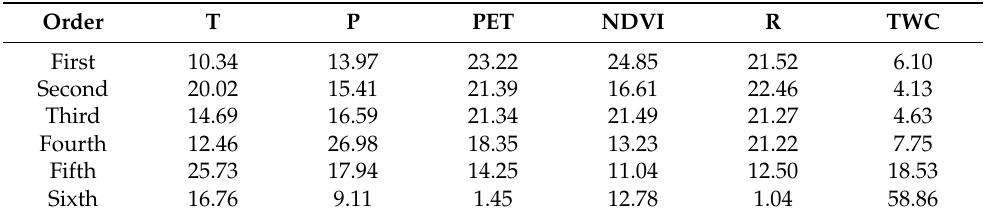
Figure 8. Map of determinants for AET at each order from Boruta. ( a ) First, ( b ) Second, ( c ) Third, ( d ) Fourth, ( e ) Fifth, and ( f ) Sixth. Table 4. The proportion of the area that is controlled by each factor in the whole of South America at each order